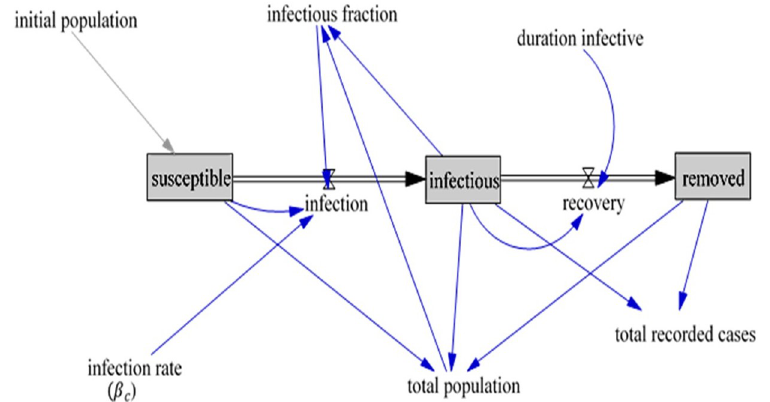
Fig 2. Flow diagram of the human population system for the derived SIR deterministic compartmental mathematical model for bubonic plague as generated in Vensim systems dynamics modeling software—Personal learning edition (PLE) version 7 for